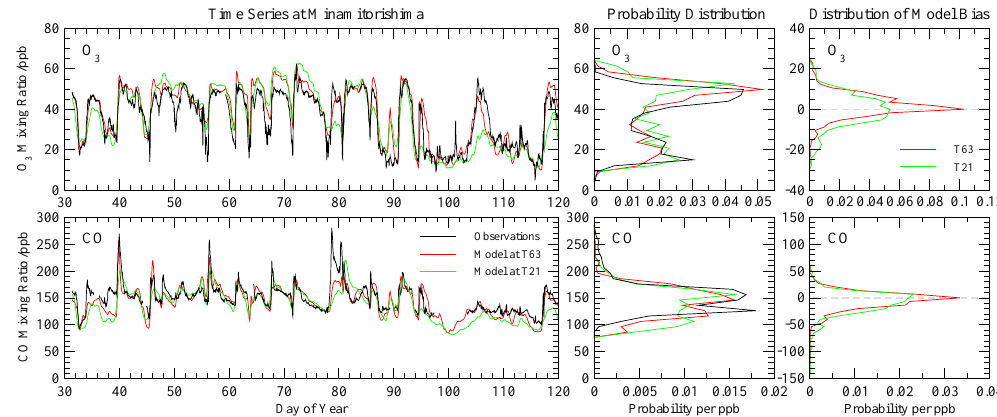
Fig. 2. Timeseries of hourly-mean surface O 3 and CO observations at Minamitorishima WMO/GAW station in February–April 2001 and FRSGC/UCI CTM results at T21 and T63 resolution. Right-hand panels show the probability distribution over the period and the distribution of the hourly model bias at each resolution.